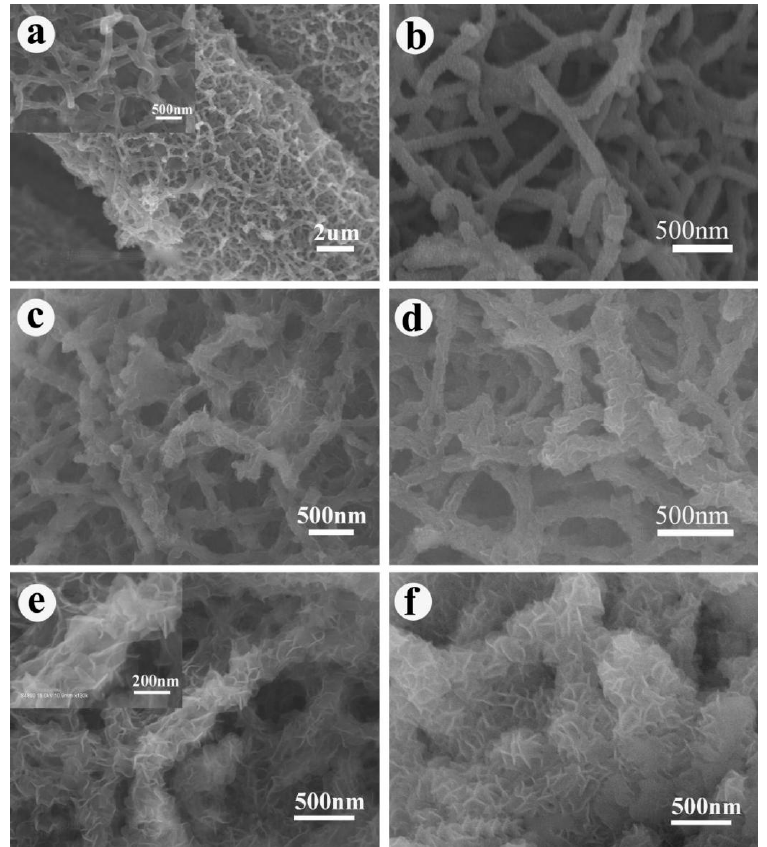
Figure 2. ( a ) FESEM micrograph of PANI network; ( b – f ) FESEM images of obtained PANI/LDH-50, PANI/LDH-100, PANI/LDH-150, PANI/LDH-200 and PANI/LDH-250, respectively; The inset in ( a ) and ( e ) shows high-magnification of respective FESEM